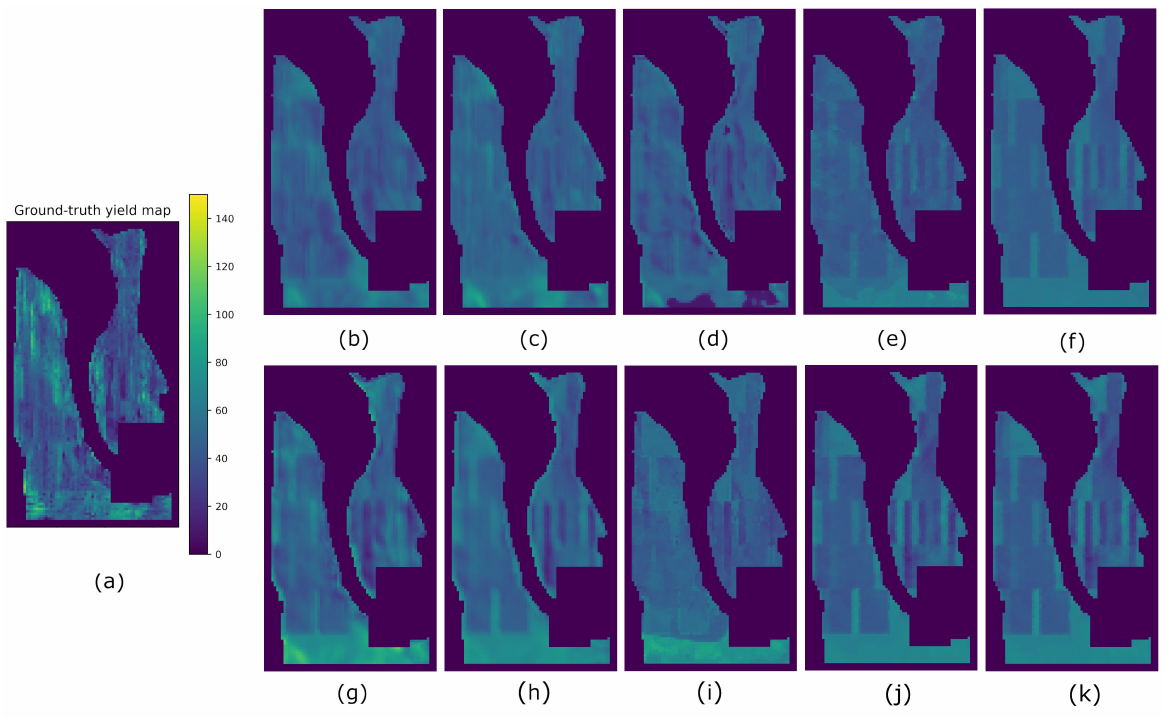
Figure 8. Yield prediction comparison on the G1 field using split A. ( a ) Ground-truth. ( b ) Hy- per3DNetReg ( N = 5). ( c ) Hyper3DNetReg ( N = 3). ( d ) Hyper3DNetReg ( N = 1). ( e ) Ad-